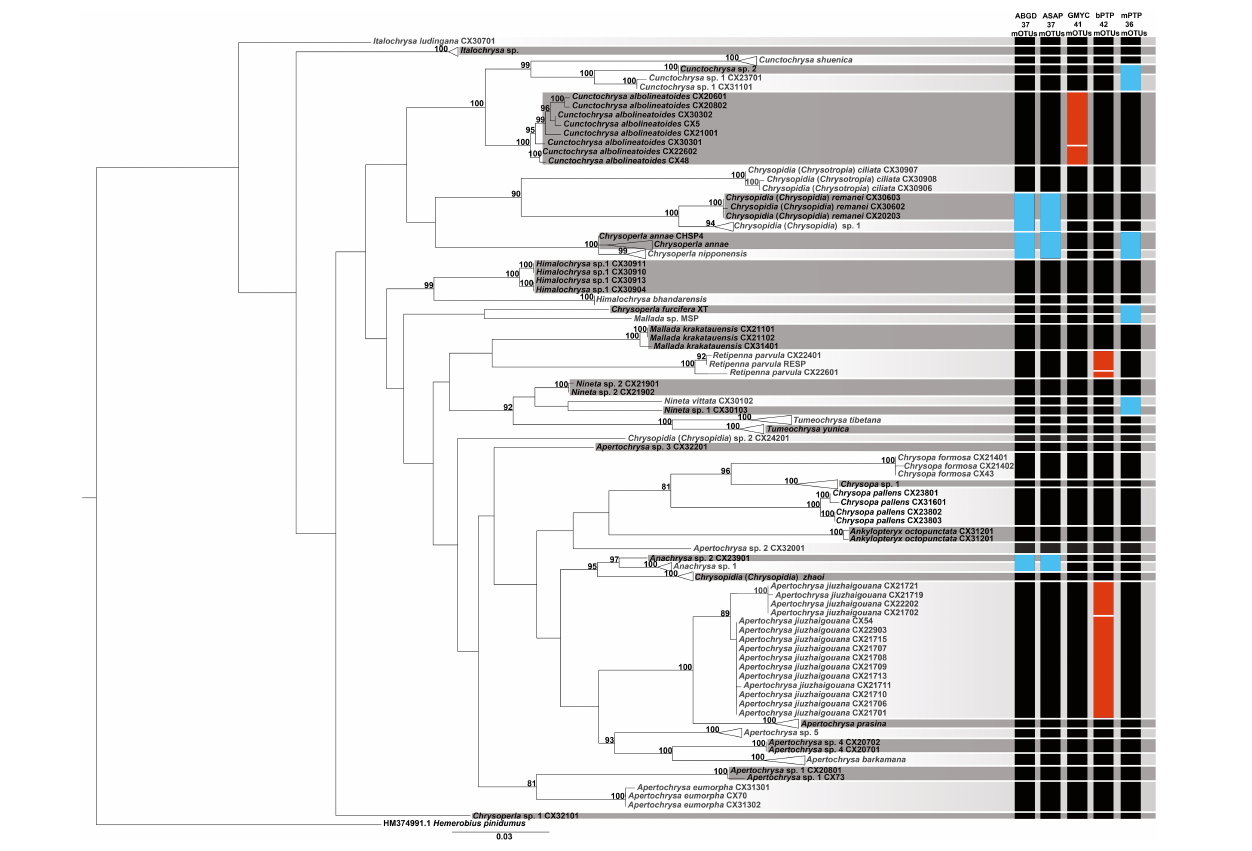
FIGURE 2 | Molecular species delimitation of the green lacewings from the Shaluli Mountains through multiple approaches based on DNA barcodes. A maximum-likelihood (ML) tree was based to summarize the results. Only the bootstrap values > 80 were given at relevant nodes. The vertical colored bars indicate putative species delimitated by the different approaches. A black bar indicates congruent results between the molecular and morphological identifications, a red bar indicates putative species divided within morphospecies, and a blue bar indicates a single putative species comprising two or more